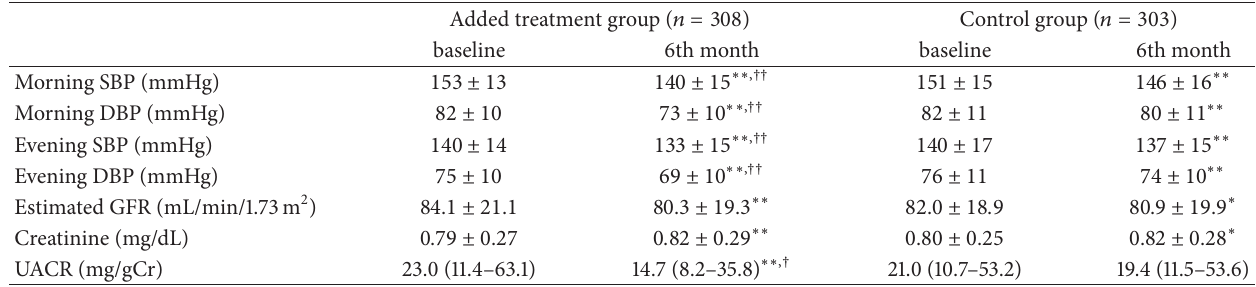
Table 2: Blood pressure and renal functional parameter changes during 6